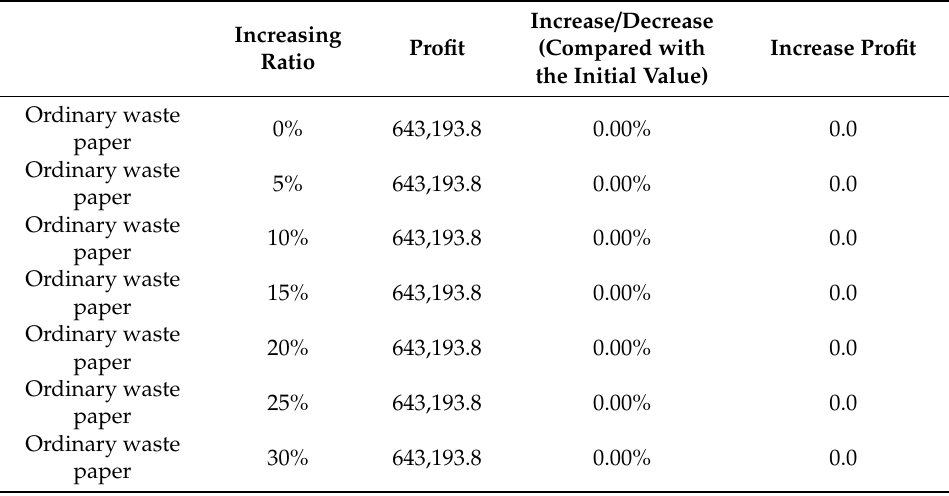
Table 8. Sensitivity analysis on the available capacity of ordinary waste